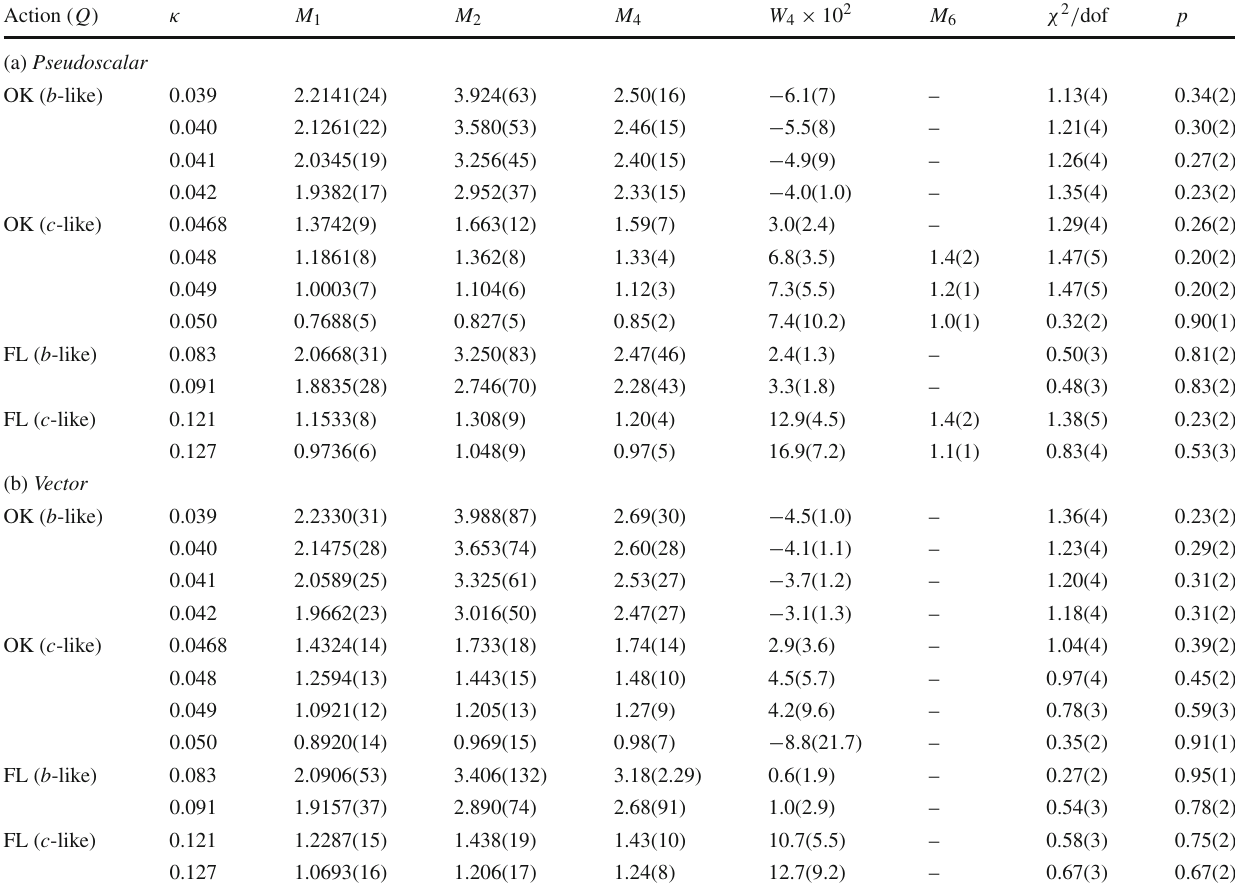
Table 4 Dispersion fit results for heavy–light mesons with masses near ( ∗ ) ( ∗ ) those of the D s and B s . The energies E are from the correlator fits to the function in Eq. (30). The first column indicates the lattice action and the (approximate) heavy-quark flavor. The second column is the hopping parameter κ . The following columns are the rest mass M 1 , the kineticmass M 2 ,thegeneralizedmasses M 4 and M 6 ,andthecoefficient